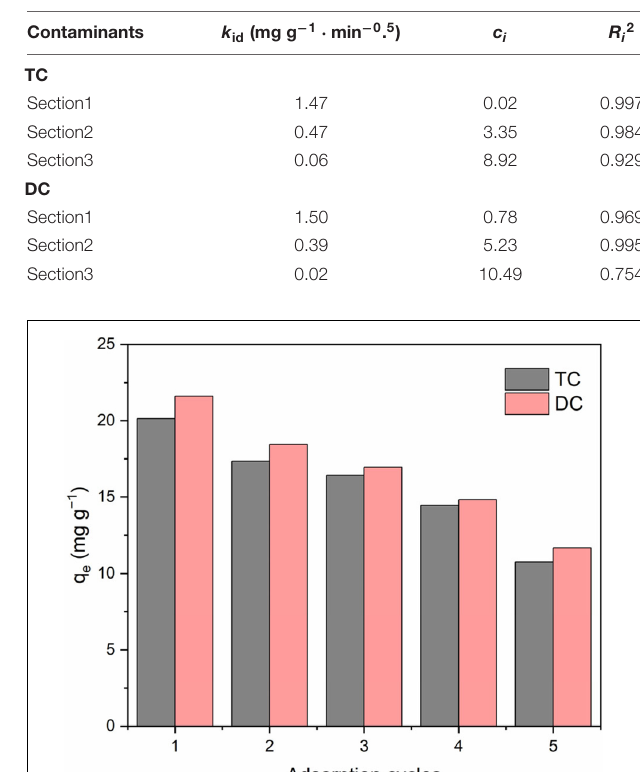
The TC and DC loaded BC/MnO 2 was desorbed using ethanol. The adsorption performance of TC and DC by BC/MnO 2 after different adsorption cycles are shown in Figure 11 . The results indicated that the adsorption capacity of BC/MnO 2 decreased gradually with the increase of cycles. After five adsorption/desorption cycles, the adsorption amount of TC and DC onto the regenerated BC/MnO 2 still remained higher than the pristine biochar, indicating that BC/MnO 2 could be